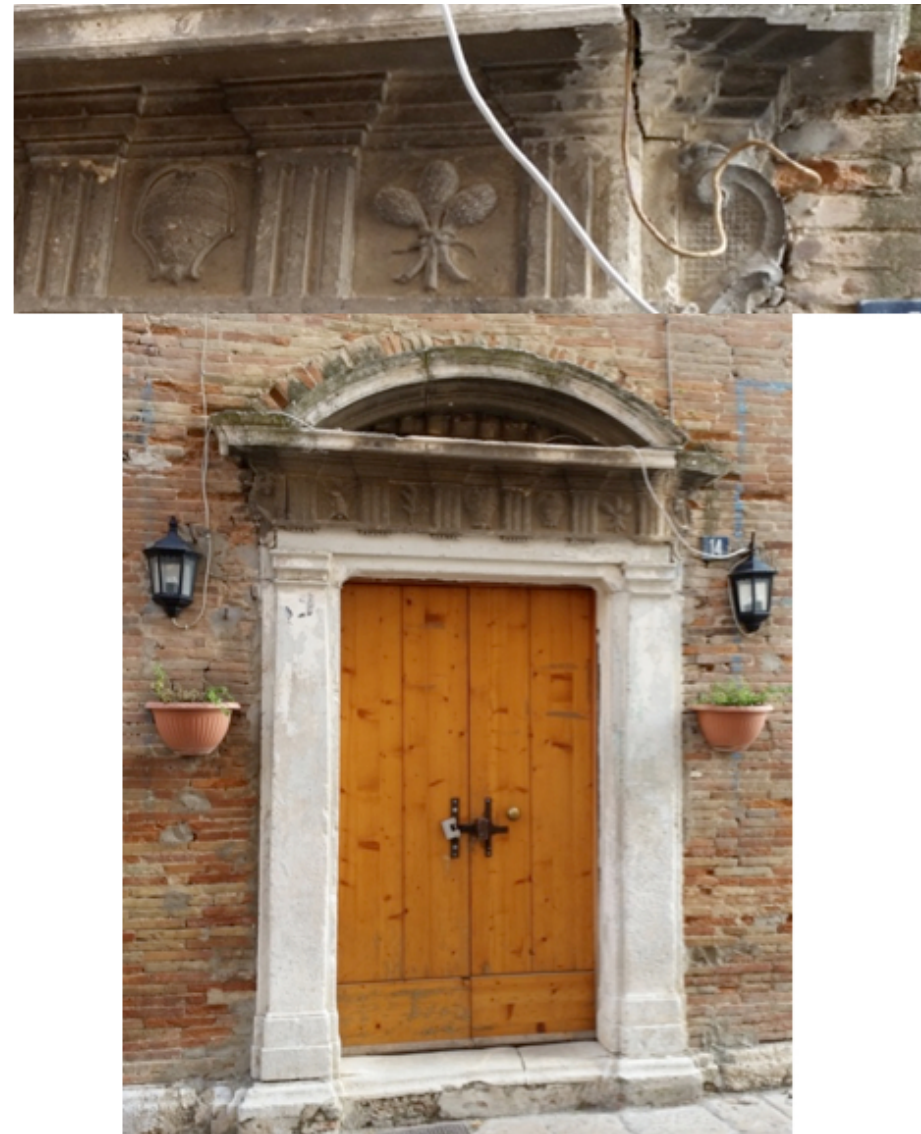
Figure 1. Door of Palazzo Lombardi (18th century). In the upper part of the picture, details of the architrave with a bunch of artichokes.